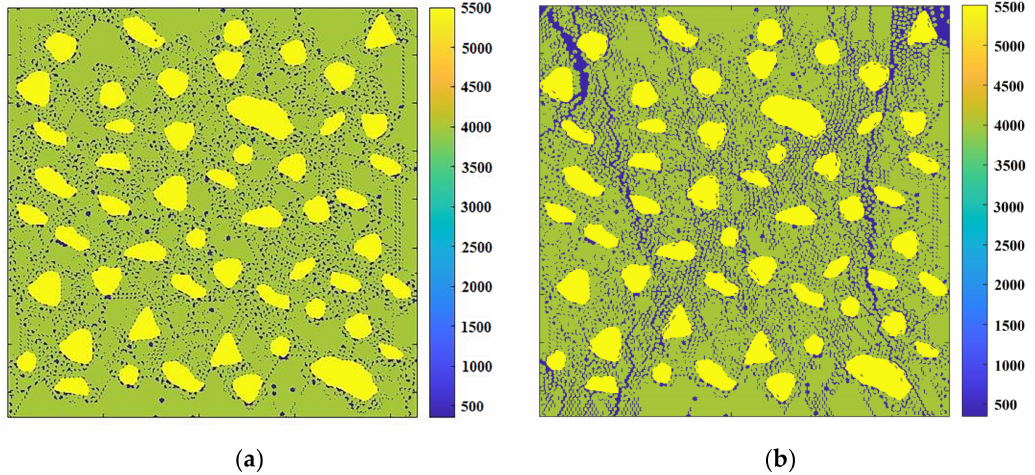
Figure 14. Numerical damage mode: ( a ) concrete ultimate strength 0%; ( b ) concrete ultimate strength